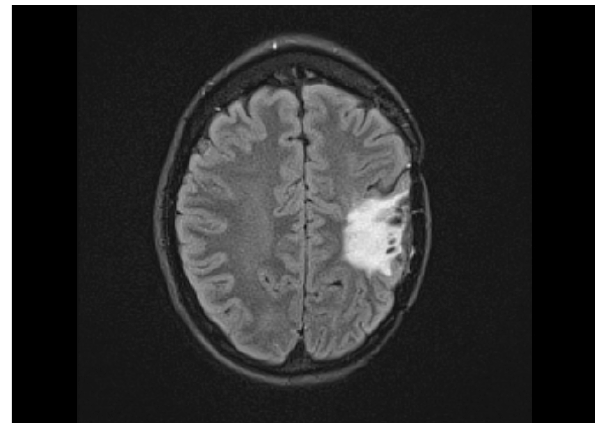
Fig. 2b. Diffusion-weighted MRI scan showing hypersignal zone in the frontal periphery of the resection